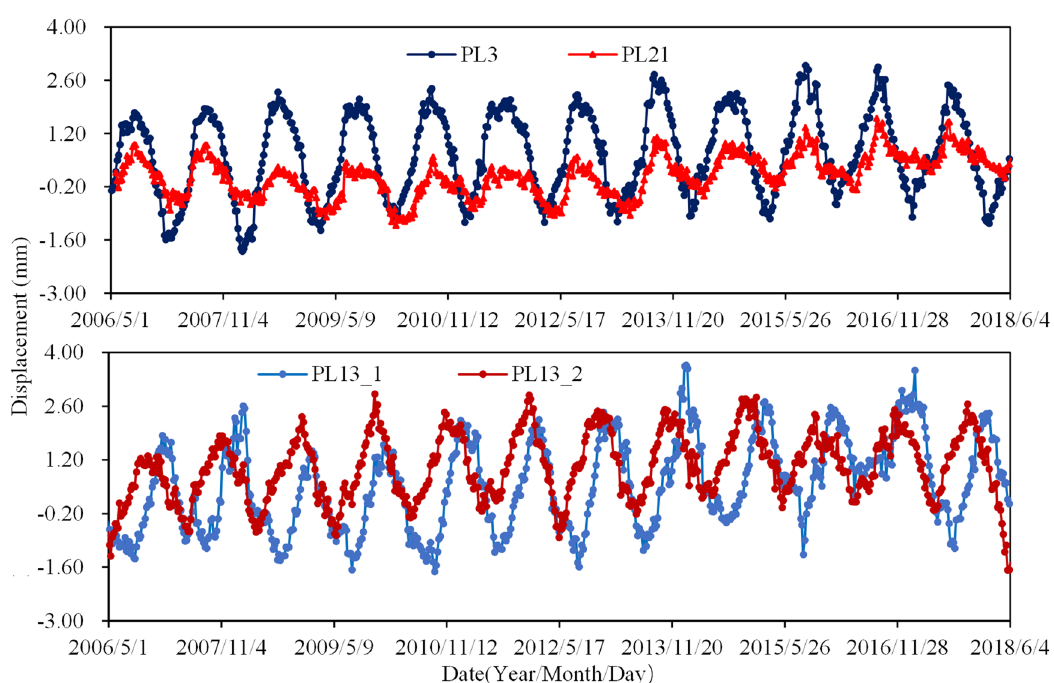
Figure 10. Radial displacements of the No. 3,13 and 21